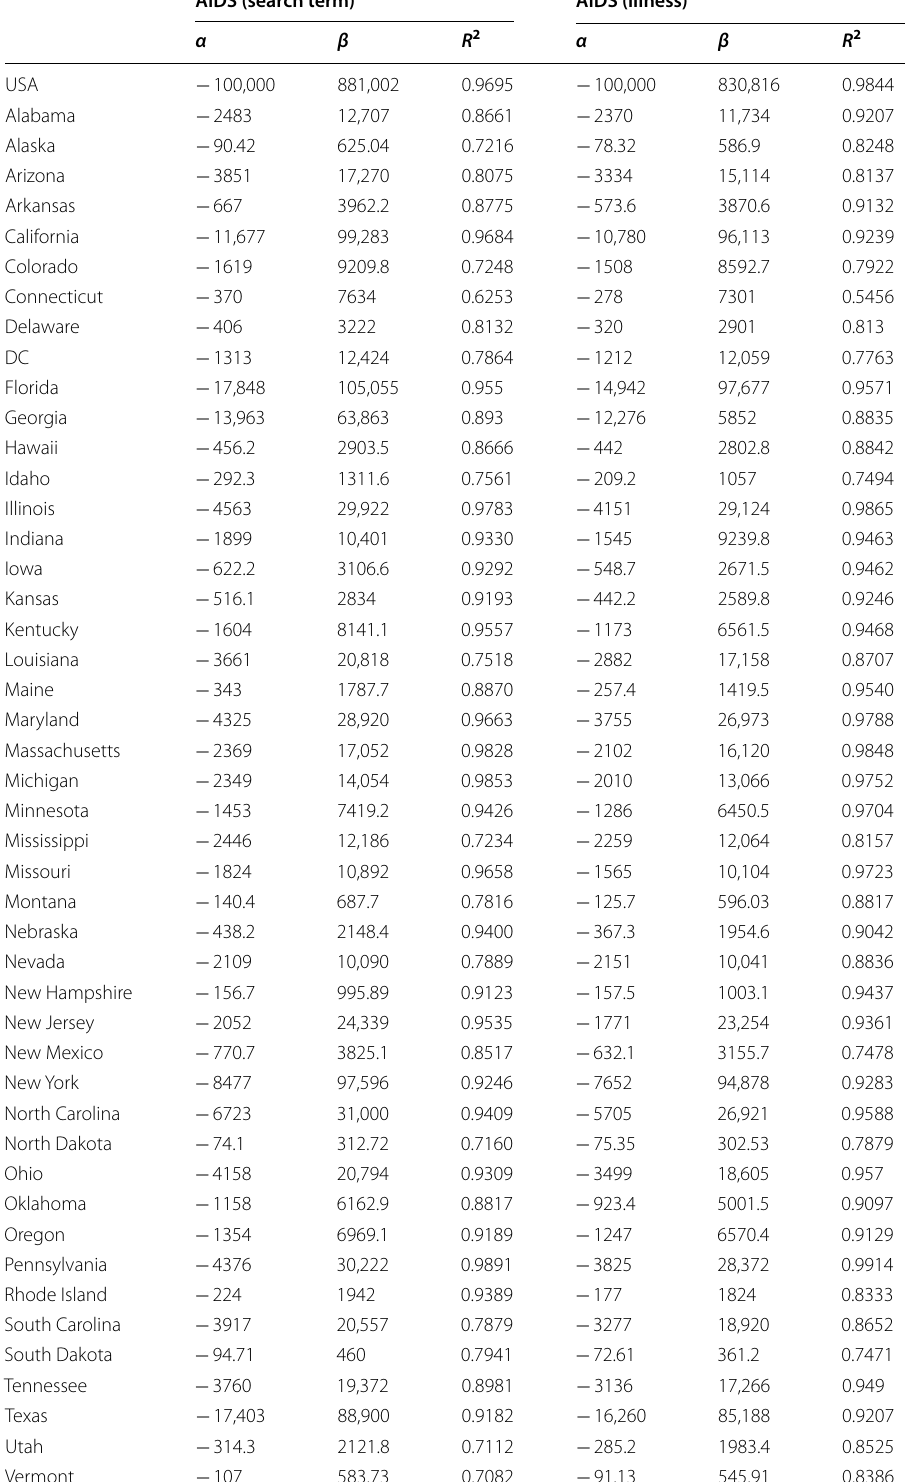
Table 4 Regression coefficients and R 2 for the estimated forecasting models for ‘AIDS